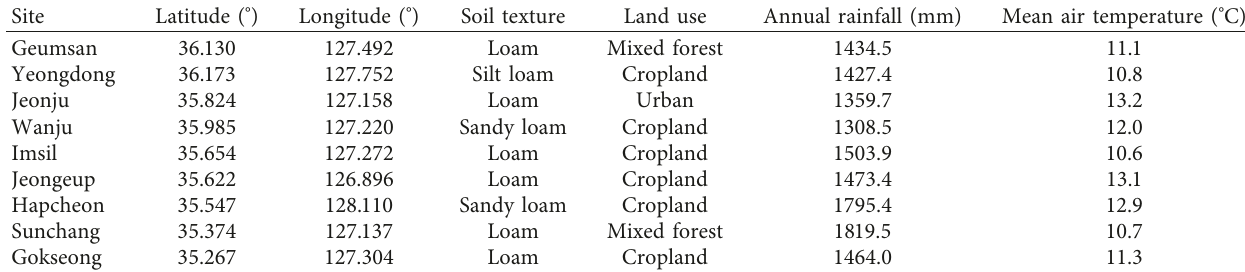
Table 1: Descriptions of the nine in situ sites.